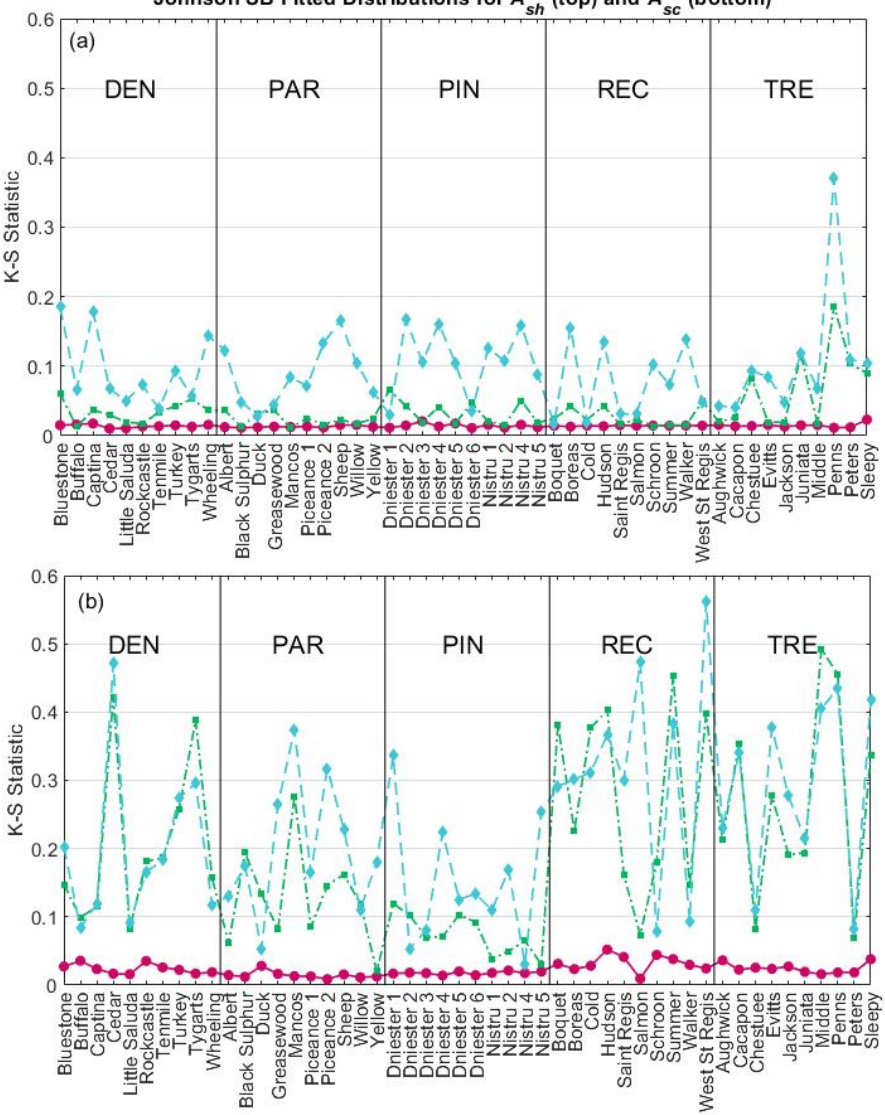
Figure 6. Kolmogorov-Smirnov (K-S) statistics for the Johnson SB distribution for ( a ) A sh and ( b ) A sc when the distribution parameters are estimated separately for each network (Method 1), based on network type (Method 2), and neglecting network type (Method 3).